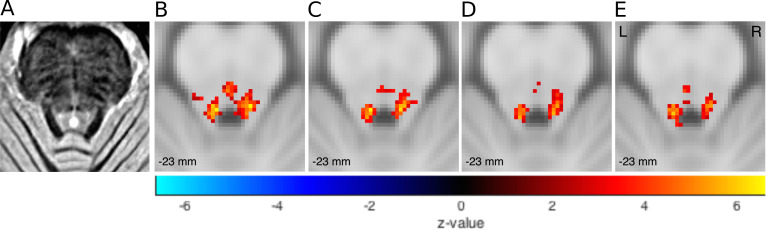
Functional template of the locus coeruleus during resting-state.Note: LC template made from all LC scans. (A) Hyperintense signal can be seen close to the 4thventricle. (B-E) Group average t-maps from dual-regression of LC component, thresholded at significance level, across preprocessing steps. (B) Spatially normalized (after motion, distortion and slice-timing correction) (C) with FIXed applied (D) with FIXed +Explicit Resp and (E) with FIXed +Explicit Phys.